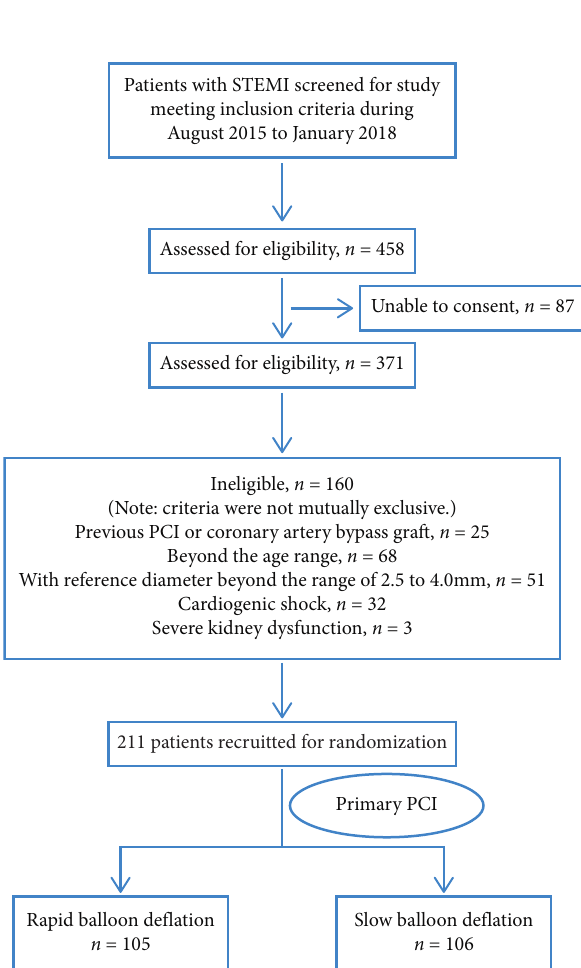
Figure 2: Flowchart of the clinical study